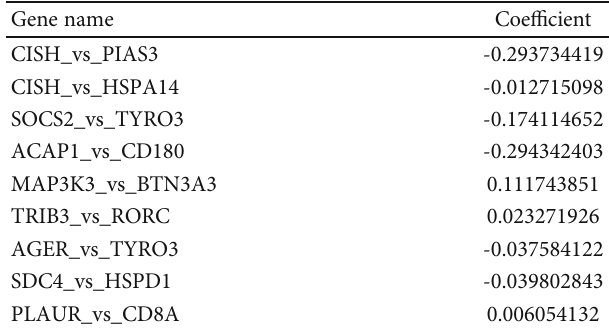
Figure 1: The association between p value and hazard ratio (HR) of 2716 IRGPS. Red nodes indicate IRGPs with log-rank p < 0 : 05 Table 1: Information about the nine-IRGP signature.